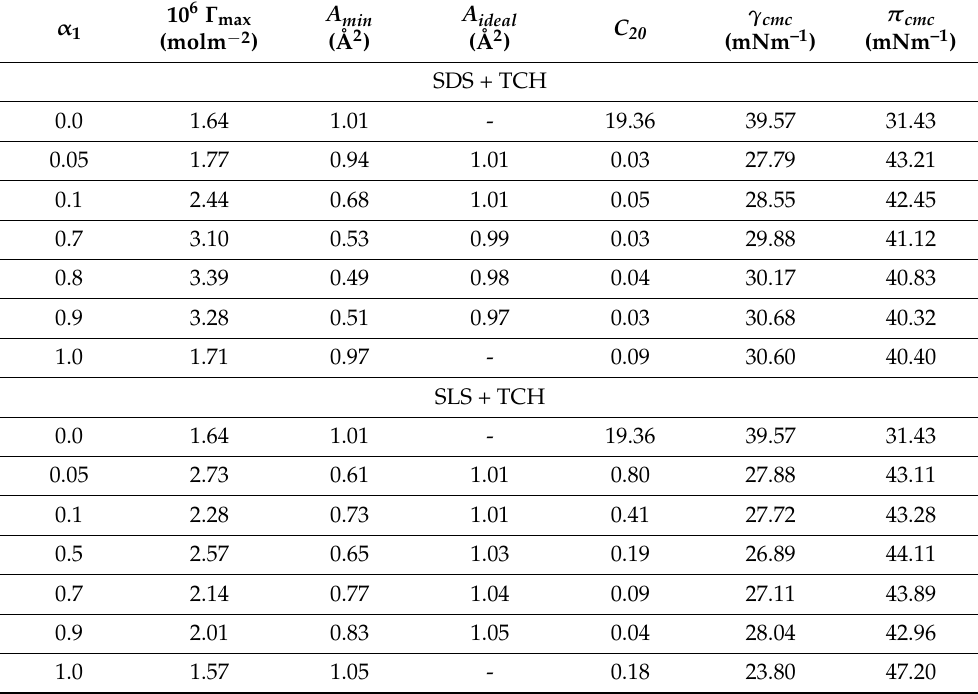
Table 3. Interfacial and packing data of TCH + SDS/SLS mixed system in aqueous NaCl a . α